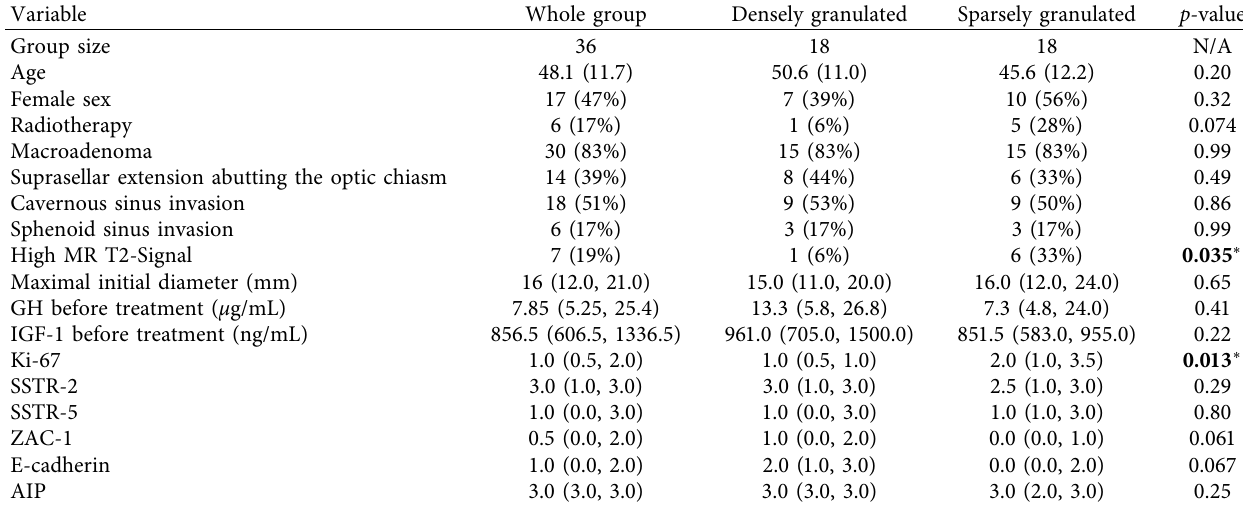
Table 1: Baseline characteristics and statistical comparisons within the entire intervention group, and stratified by sparse or dense tumor granulation. ∗ p ≤ 0.05.